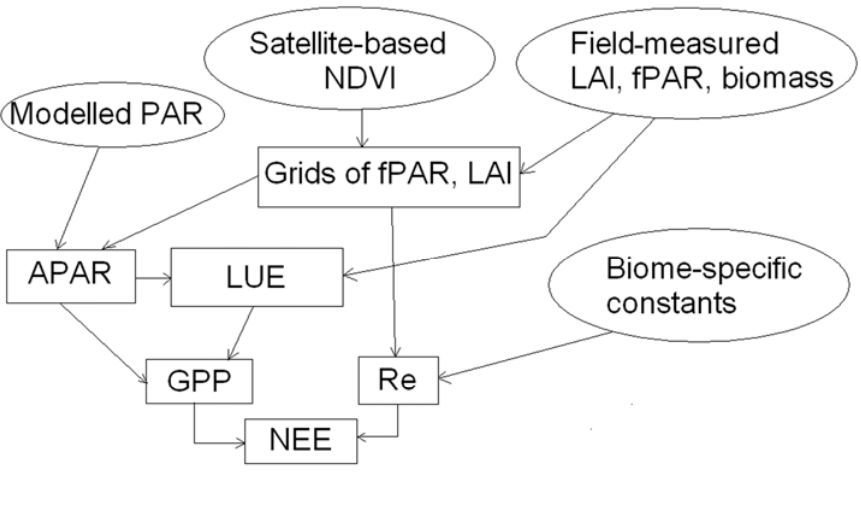
Figure 2. Flowchart of the NEE